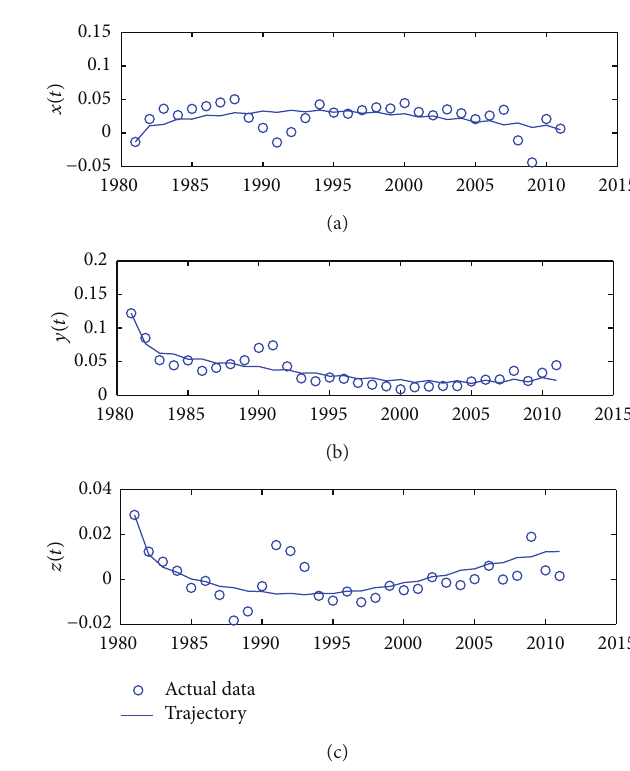
Figure 2: The actual data versus trajectories of fractional-order system in each dimension about Australia.